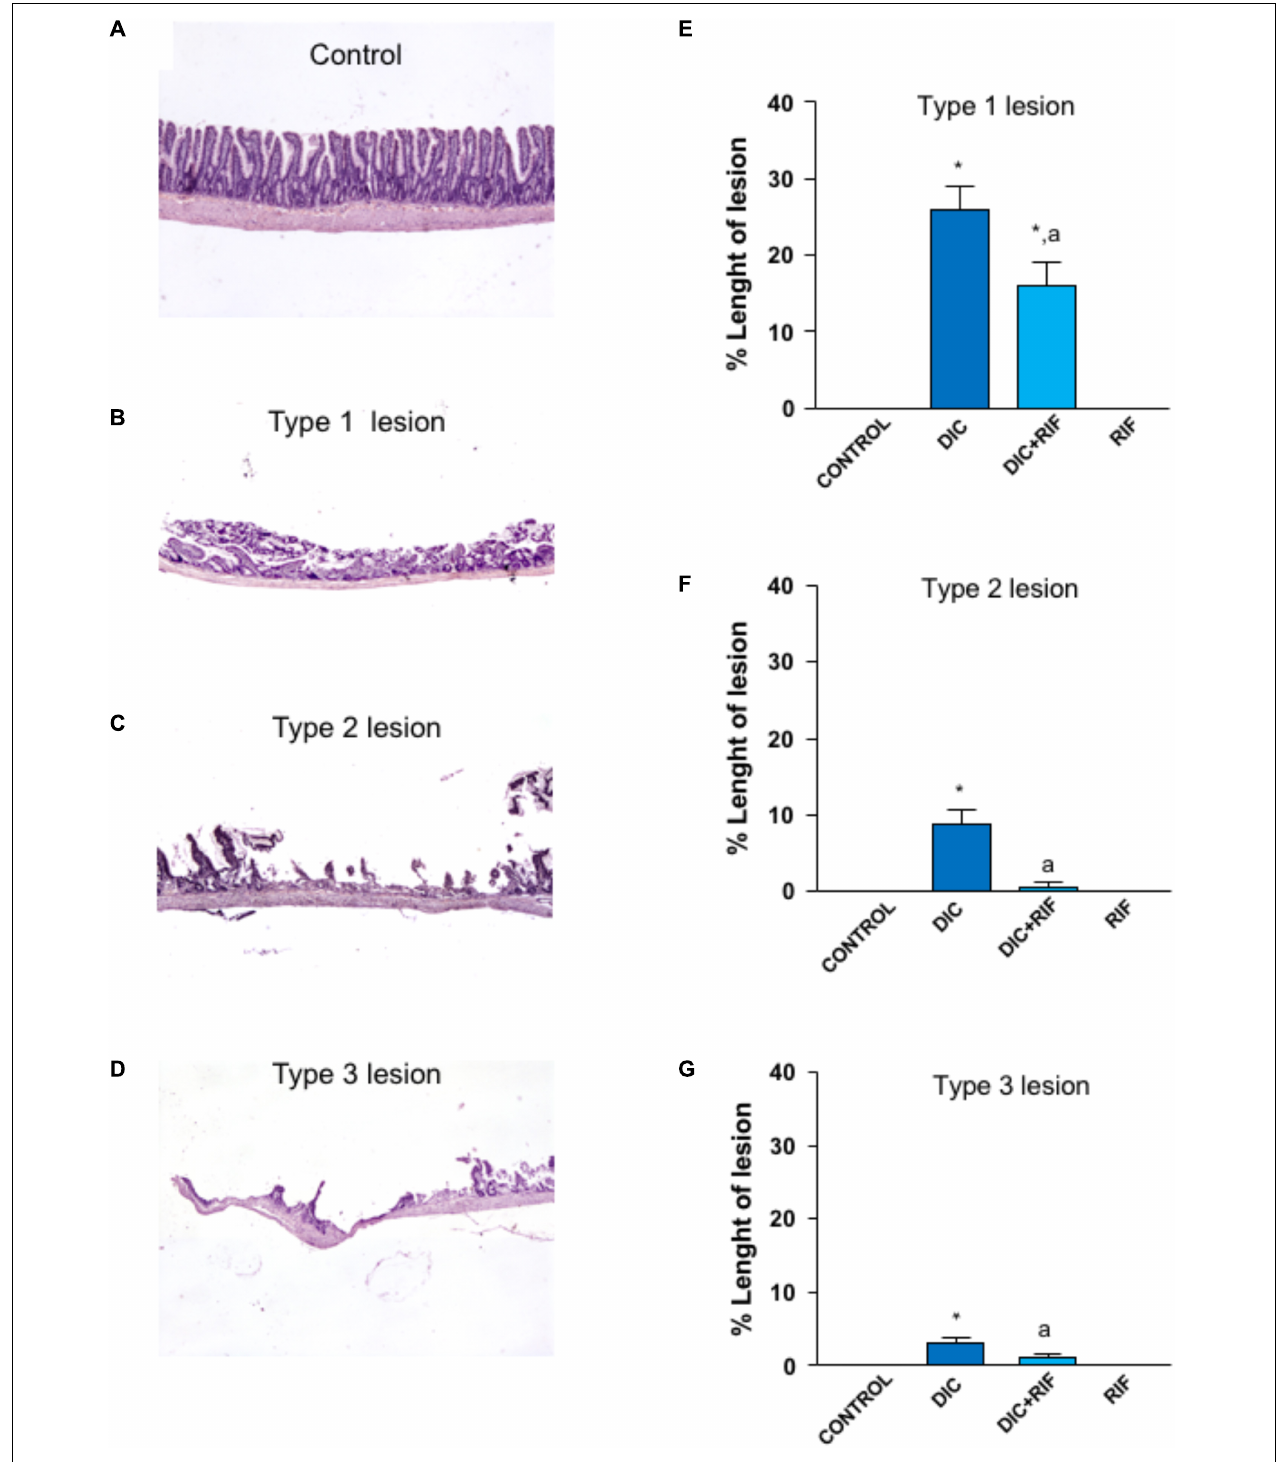
FIGURE 1 | Histological analysis of damage in the ileum of rats treated with vehicle (Control), diclofenac (DIC, 4 mg/kg BID), diclofenac plus rifaximin (DIC+RIF, 50 mg/kg BID), or rifaximin (RIF) for 14 days. Representative pictures showing the microscopic appearance of ileal mucosa from control animals (A) , as well as type 1 (B) , type 2 (C) or type 3 (D) lesions, observed in animals treated with DIC. Effects of treatments on type 1 (E) , type 2 (F) , or type 3 (G) lesions. Each column represents the mean ± SEM obtained from 10 animals. ∗ p < 0.05, significant difference versus Control; a p < 0.05, significant difference vs. diclofenac alone.